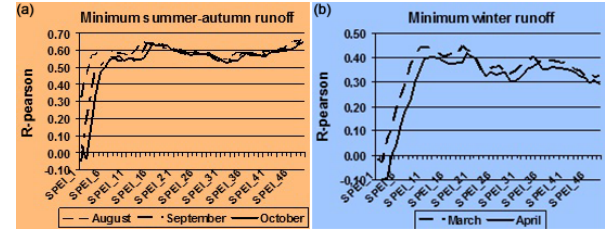
Figure 10. Correlation between the minimal river runoff and SPEI on scales of 1–48 months for the river Southern Bug – village Olek-